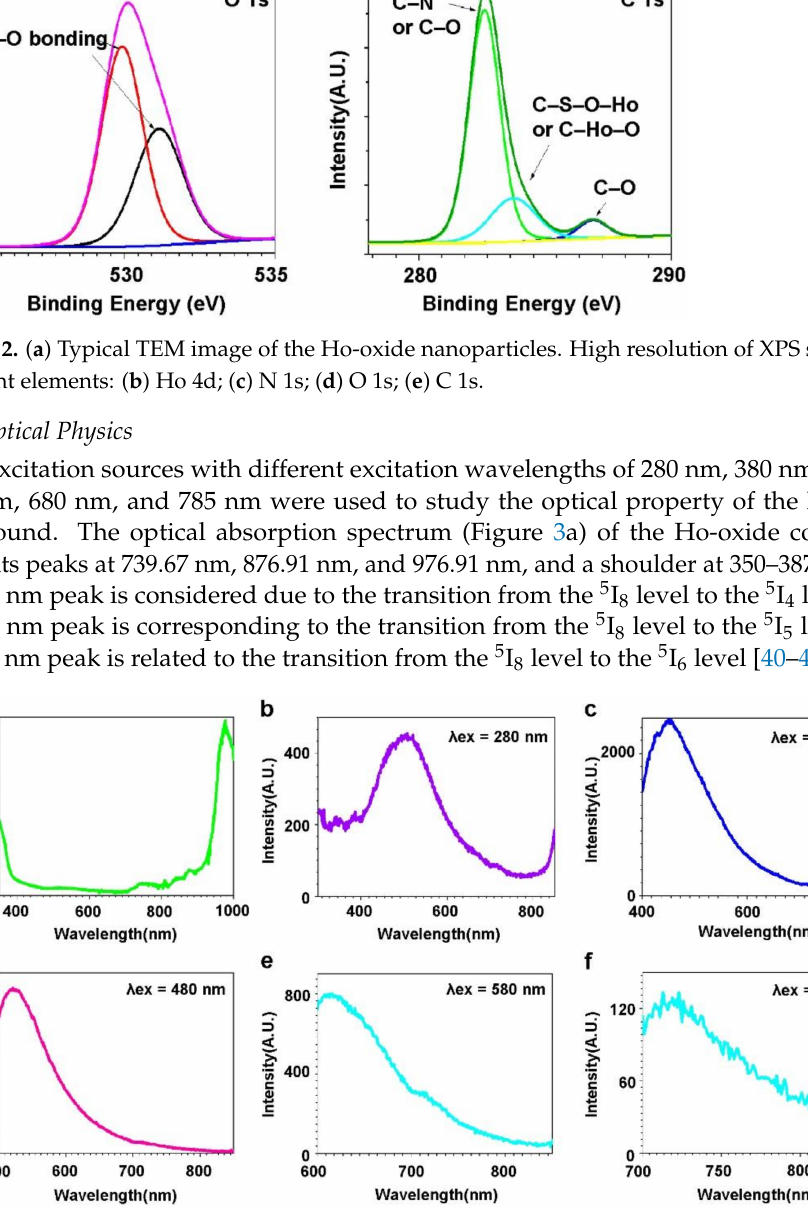
Figure 3. Optical property of Ho-oxide compound. ( a ) Optical absorption is plotted. Fluorescence spectra with different excitation are investigated: ( b ) 280 nm; ( c ) 380 nm; ( d ) 480 nm; ( e ) 580 nm; ( f ) 680